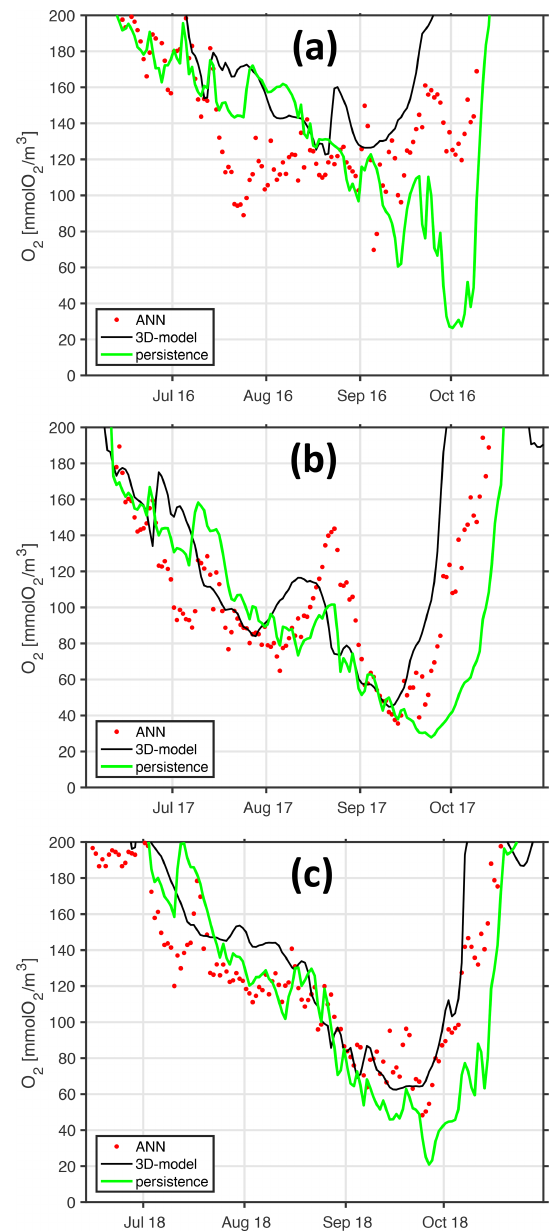
Figure 20. Walk-forward validation (generalization) of ANN. Pan- els (a–c) refer to years 2016, 2017, and 2018. The black line shows bottom oxygen concentrations at the monitoring station Buoy 2a as simulated with the full-fledged and computationally expensive 3-D coupled ocean circulation biogeochemical model. Each of the red dots denotes a respective biweekly walk-forward (computationally cheap) ANN forecast utilizing surface and bottom temperatures at station Boknis Eck only. The green line features a naive biweekly persistency forecast based on bottom oxygen concentrations from station Boknis Eck for